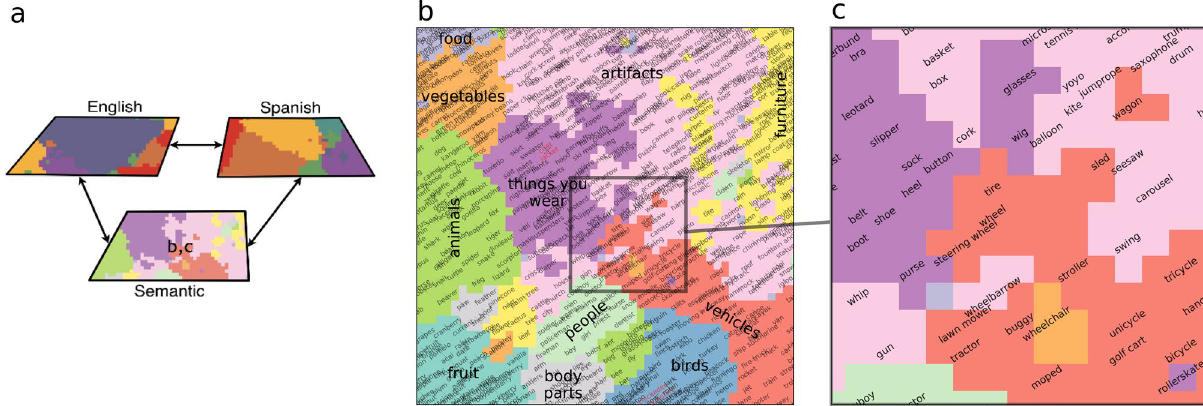
Figure 1. ( a ) The BiLex model consists of three interconnected SOMs, one for word meanings shared across languages, and two for their phonetic representations in L1 and L2. Bidirectional associative connections transfer activation between maps. ( b ) The semantic map organizes the model’s vocabulary according to word meanings, such that similar words are close together on the map. Plot c shows a detail of this map. Phonetic maps are organized in the same way, but reflect phonetic similarity. Created using Matplotlib v3.2.1 (https:// matplotlib.org) 35